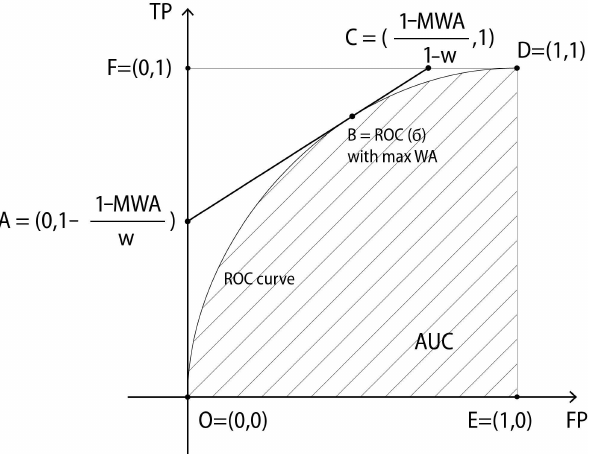
Figure 1. The ROC curve and the tangent line at a maximally weighted average point. The line (cid:96) = { ( FP ( σ ) + wt , TP ( σ ) + ( 1 − w ) t ) , t ∈ R } , where σ gives the maximally weighted accuracy for the machine M , cuts the boundary of the unit square at two points 1 − MWA 1 − MWA ) and C = ( A = ( 0, 1 − , 1 ) . The triangle (cid:52) ACF , where F = ( 0, 1 ) , w 1 − w